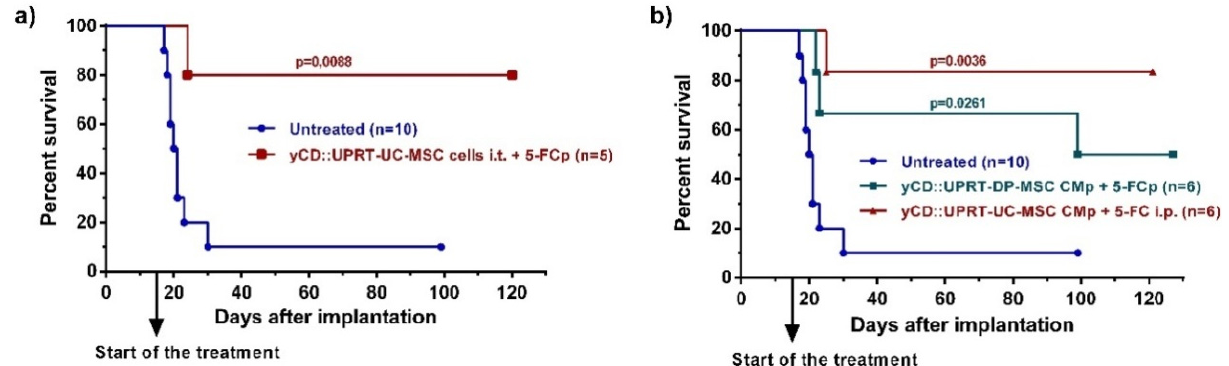
Figure 3. Rat glioblastoma C6 growth inhibition mediated by human yCD-UC-MSC-exosomes in vivo. Tumors were induced by 5 × 10 5 C6 cells inoculated intracerebrally. Animals began treatment with CM from yCD-DP-MSCs and yCD-UC-MSCs applied continuously by an ALZET osmotic pump Model 2ML2 intratumorally with one exchange for a fresh pump. The prodrug (5-FC; 500 mg/kg of body weight) was delivered i.p. three times per week or continuously by an ALZET osmotic pump. Animals were killed on day 100 or 120, and their brains were inspected by histopathology. ( a ) Survival of rats bearing intracerebral C6 glioblastoma cells treated with 10 5 yCD::UPRT-UC-MSCs implanted intracerebrally. The prodrug was delivered by an ALZET osmotic pump ( b ) Survival of rats bearing intracerebral C6 glioblastoma cells treated with yCD::UPRT-DP-MSC-CM and yCD::UPRT-UC-CM applied by an ALZET osmotic pump. Statistical significance was determined by comparison to the untreated animal group. 5-FCp, 5-fluorocytosine delivered by an osmotic pump; CMp— conditioned medium delivered by an osmotic pump .